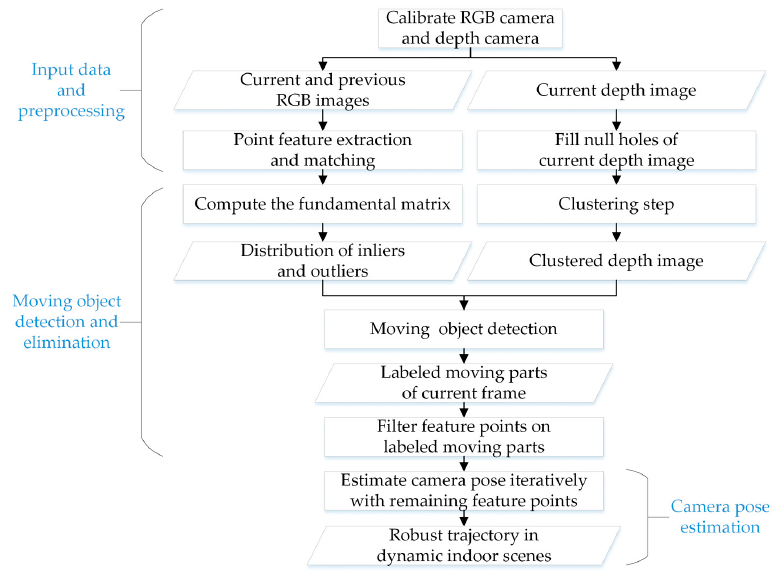
Figure 1. Flowchart of the proposed moving object detection based RGB-D SLAM